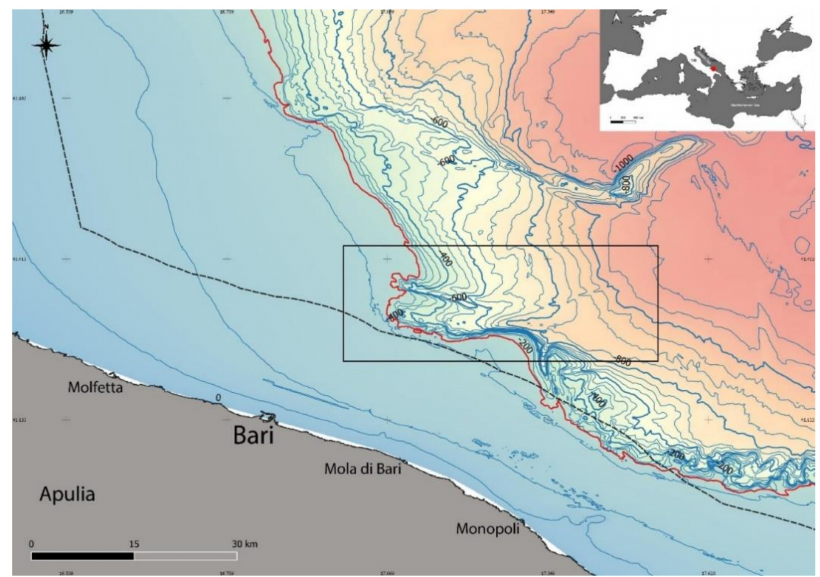
Figure 1. Location of the Bari Canyon (red circle in the inset) with the location of the main ports hosting fishing fleets operating in the area. Bathymetry from http://www.emodnet-bathymetry.eu/ (accessed on 16 April 2021). The black rectangle highlights the two branches oriented east-west of the Bari Canyon. The dashed black line indicates the limit of Italian territorial waters (12 nautical miles), the blue contour lines are spaced each 50 m, and the red line shows the bathymetric limit of 200